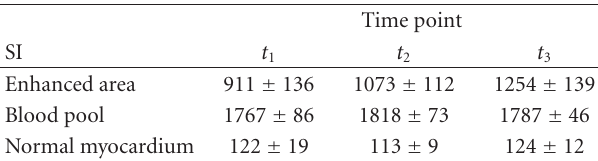
Table 1: Averaged signal intensities (SIs) in the enhanced area, blood pool, and normal myocardium at each time point. Values are expressed as mean ± standard